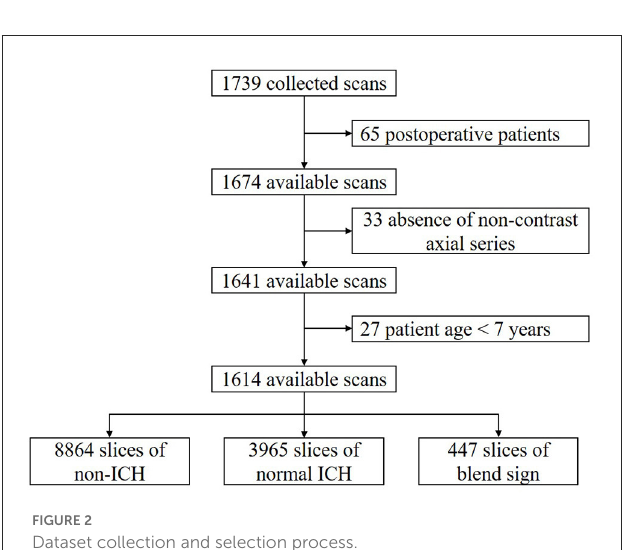
FIGURE2 Dataset collection and selection